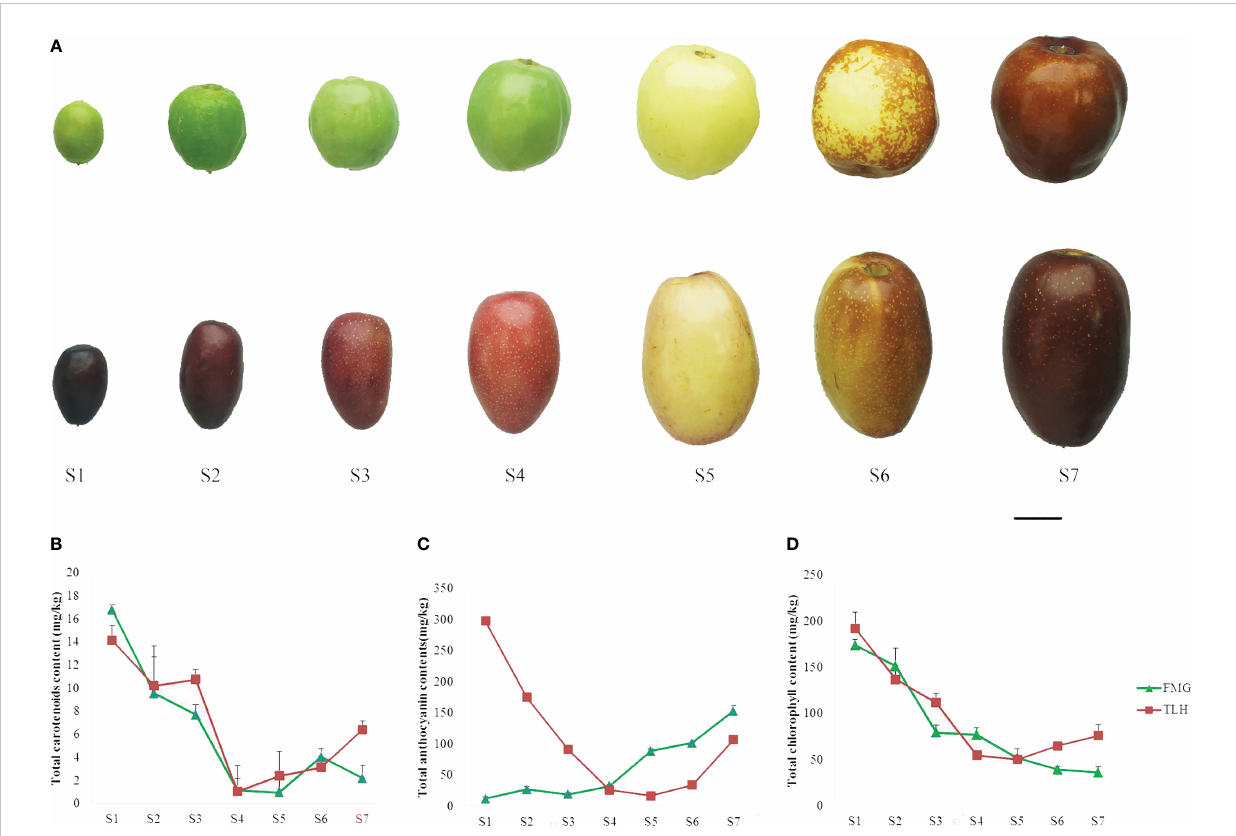
FIGURE 1 Phenotypic characterization of the jujube cultivars FMG and TLH. (A) Photographs of the seven stages of growth. Bars = 1 cm. (B) Total carotenoid content. (C) Total anthocyanin content. (D) Total chlorophyll content. Error bars indicate standard deviations (SDs) from three biological